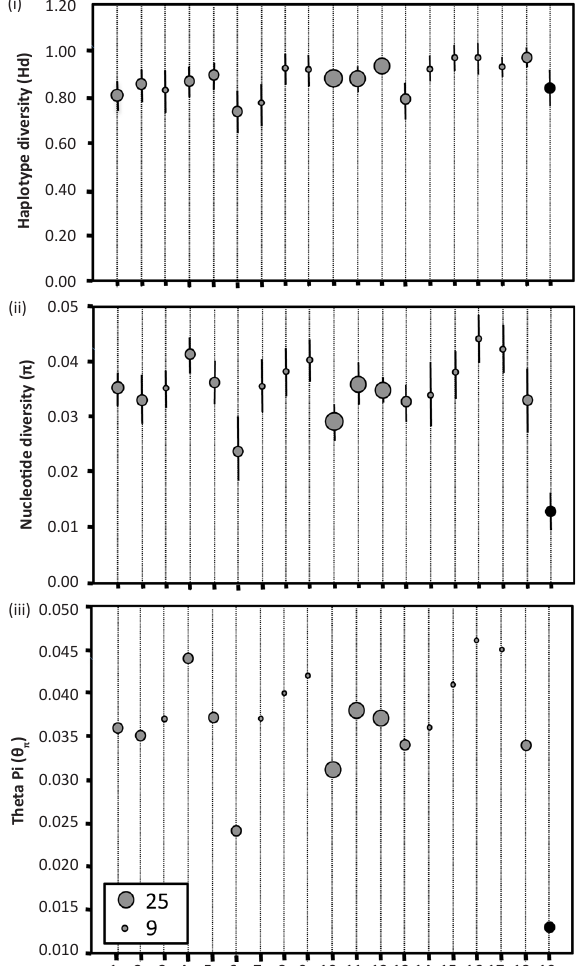
1 2 3 4 5 6 7 8 9 10 11 12 13 14 15 16 17 Figure 3. Comparison of genetic diversity indices between Hamadryas and Guinea Baboons. The X-axis represents pairs of demes (social units) which were separated by 50 to 100 km. (i) Haplotype diversity ± standard deviation; (ii) Nucleotide diversity ± standard deviation; (iii) Theta Pi (θ ). Grey symbols correspond π to hamadryas baboons and black symbols to Guinea baboons. The sizes of the circles are proportional to the sampling effort (the circles area representing 25 sequences and 9 sequences are showed for reference). 1 - Furrus-Abdur, 2 - Furrus-Dogali, 3 - Furrus-Debresina, 4 - Furros-Geleb, 5 - Furros-Molki, 6 - Durfo-Abdur, 7 - Durfo- Dogali, 8 - Durfo-Molki, 9 - Durfo-Barka River, 10 - Arborobo-Abdur, 11 - Arborobo-Geleb, 12 - Arborobo-Molki, 13 - Abdur-Dogali, 14 - Dogali-Kubkub, 15 - Debresina-Molki, 16 - Debresina-KubKub, 17 - Geleb-Kubkub, 18 - Molki-Barka River, 19 - MB-Caiquene